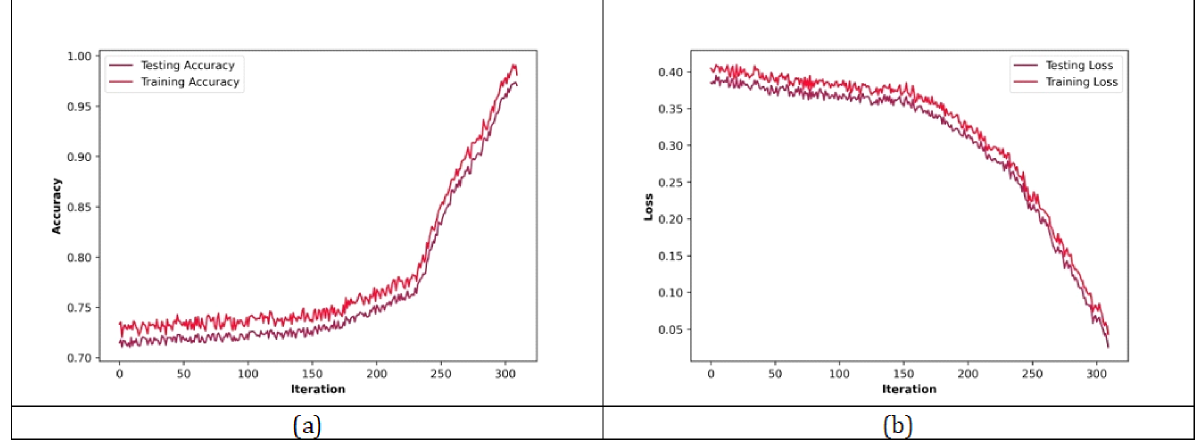
Figure 11. Performance analysis based on ( a ) accuracy and ( b ) loss for Review Rating Prediction using social media app review